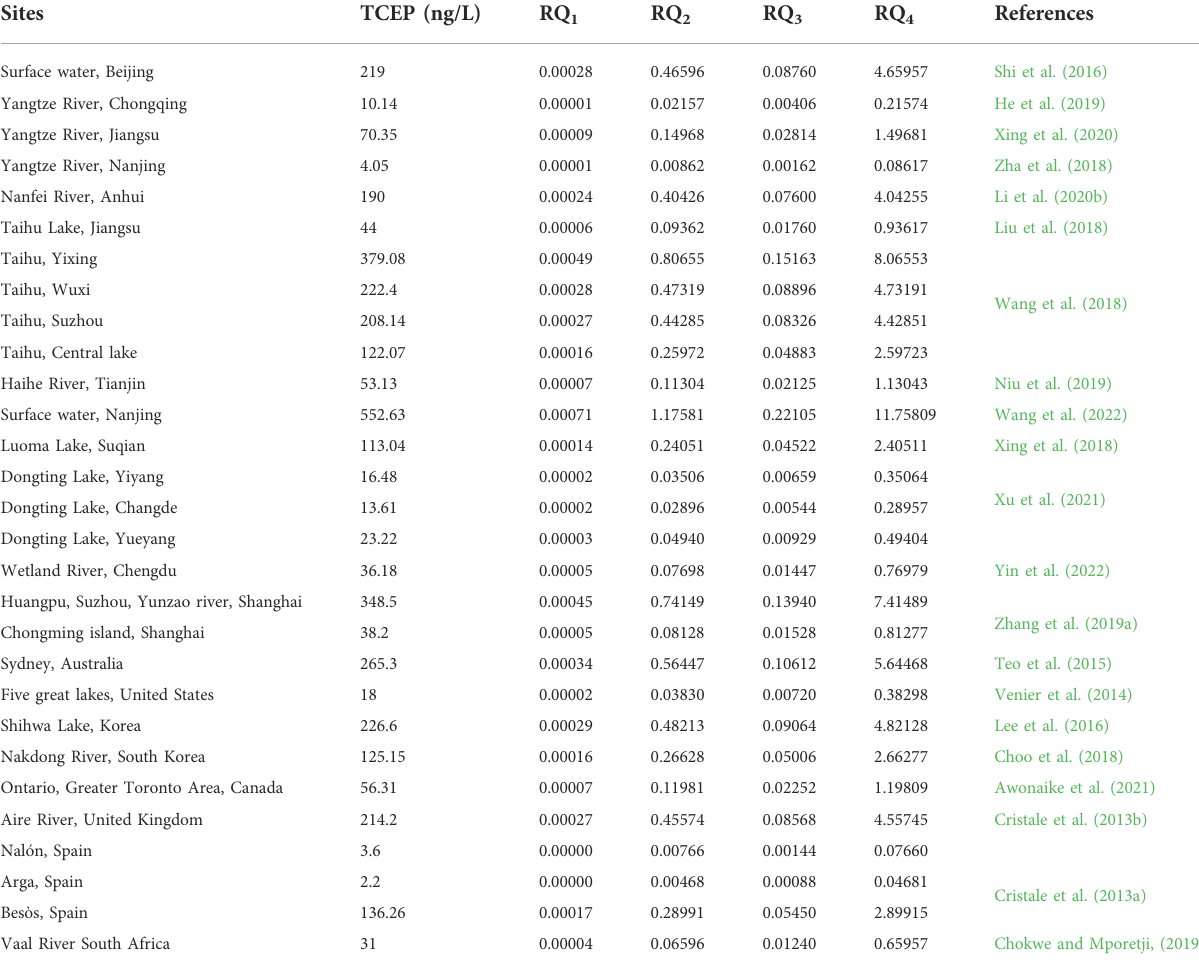
TABLE 3 Mean environmental concentration and RQ value of TCEP in freshwater in several